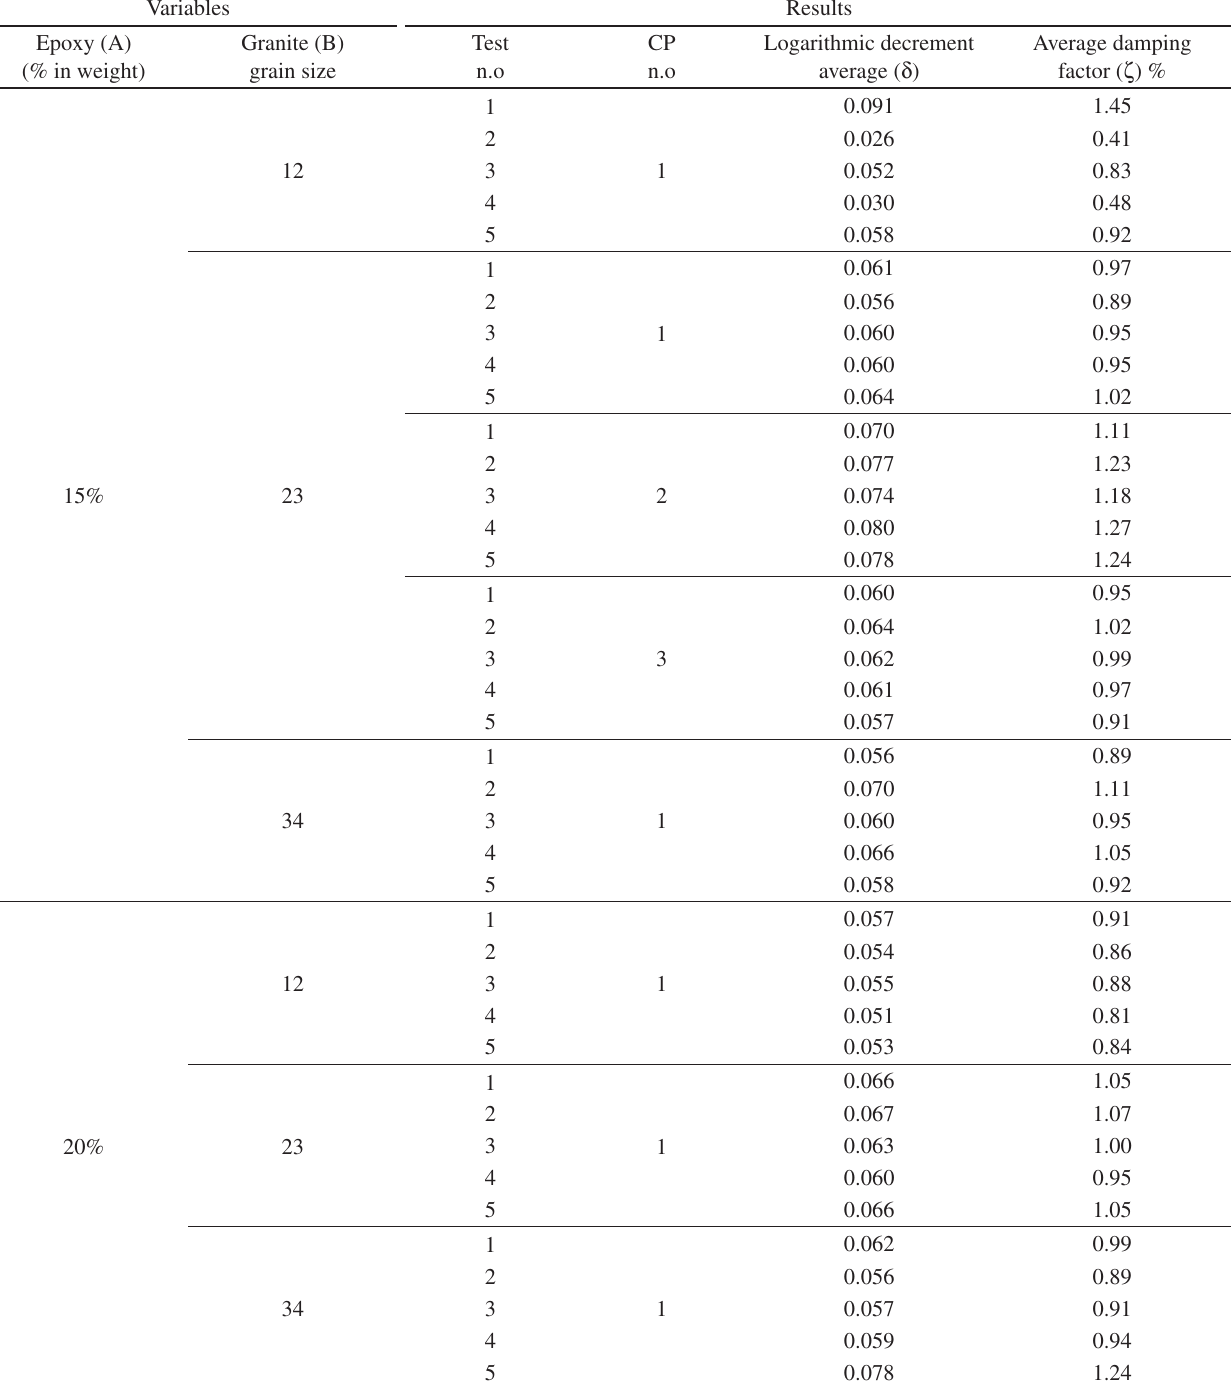
Table 3. Average logarithmic decrement and damping factor of the granite-epoxy PSs. Variables